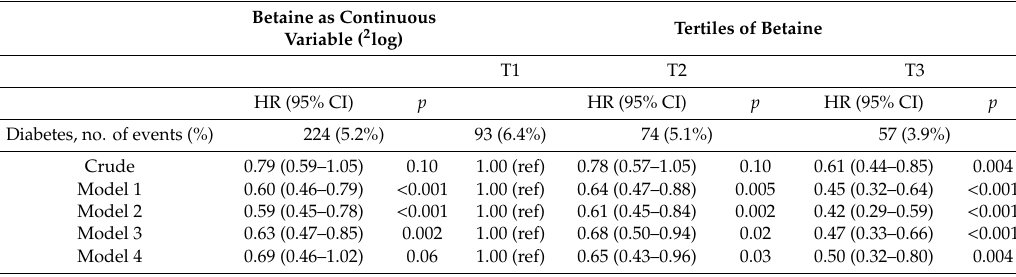
Table 4. Association of betaine as a continuous variable and according to tertiles with the development of T2DM.